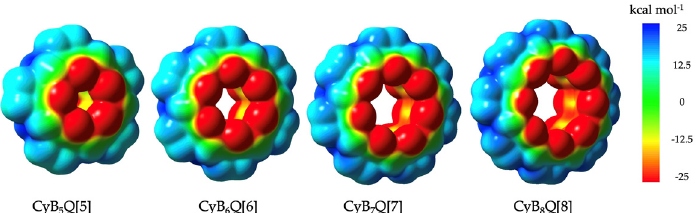
Figure 6. Electrostatic potential maps (ESPs) for CyB 5 Q[5], CyB 6 Q[6], CyB 7 Q[7], and CyB 8 Q[8], respectively. Table 2. Relative ESP mapped energies (kcal mole − 1 ) of classical Q[ n ] and CyB n Q[ n ] comparing the surfaces of their cavities, equatorial regions, and portals.